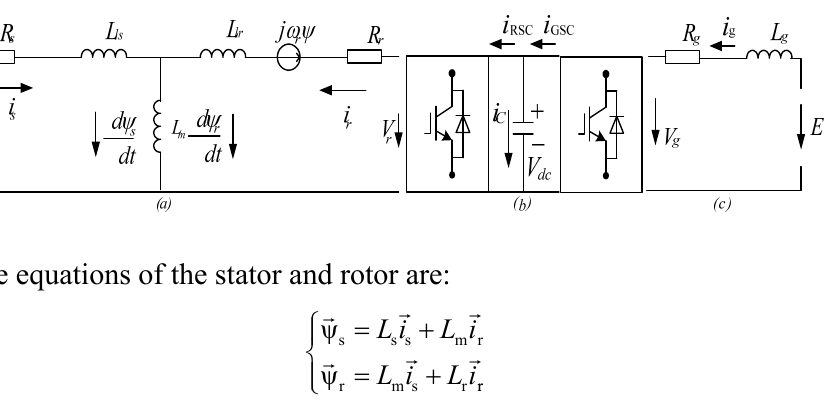
Figure 3. Equivalent circuit of: ( a ) DFIG from the stator side; ( b ) DC link; and ( c ) External